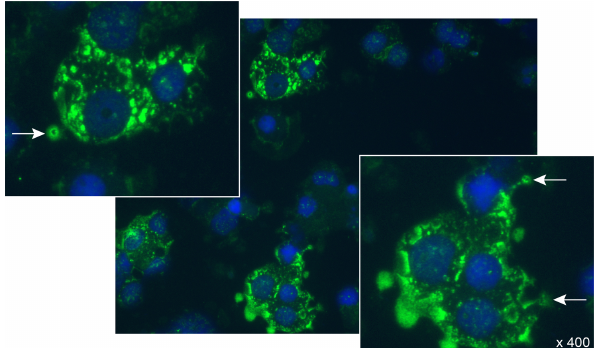
Figure 13. LC3 staining of EBV-infected human B lymphoblastoid cells (BLCs). Cytospin preparations of stably growing cells were prepared, fixed and stained with anti-LC3 + GAM-FITC conjugate. Arrows point to small LC3 + bodies, which seem to be shed from the